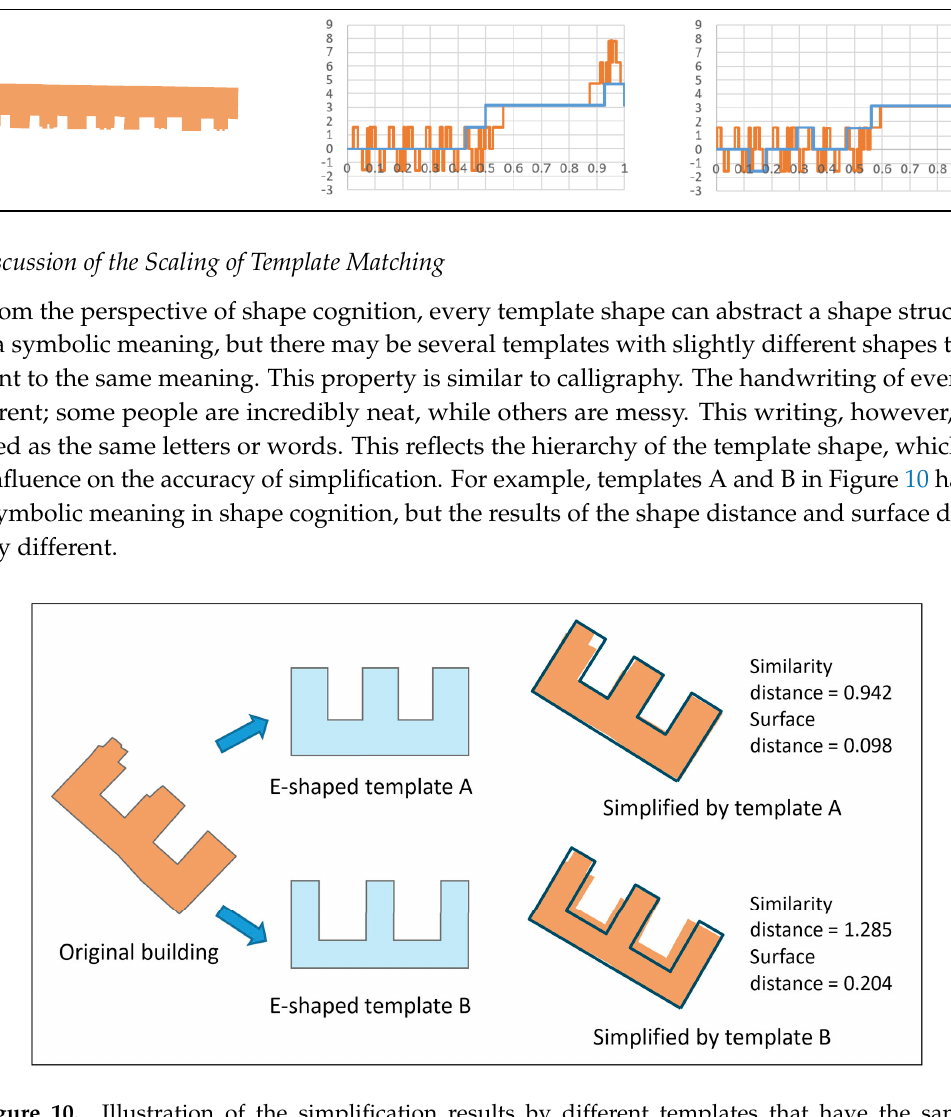
Figure 10. Illustration of the simplification results by different templates that have the same symbolic meaning.